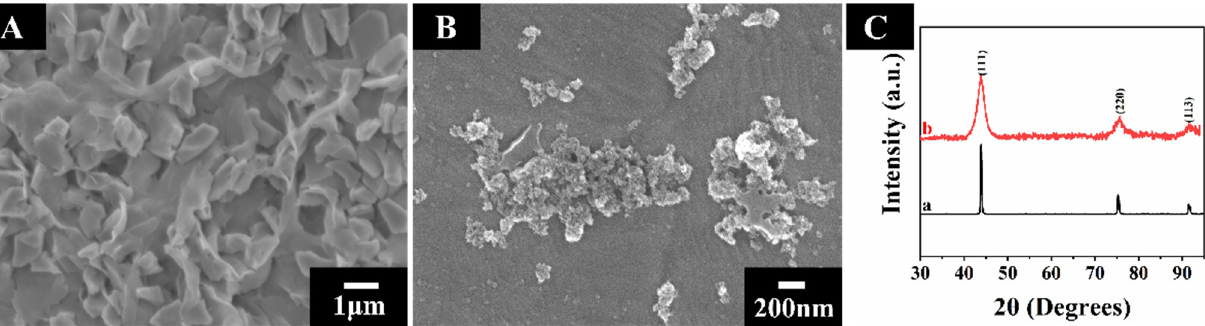
Figure 3. ( A , B ) SEM and ( C ) XRD data for films prepared from 1 gL ⁻ 1 CBXNa 2 solutions with ( A , C (a)) 1 gL ⁻ 1 diamond at 7 V in water and ( B , C (b)) 1 gL ⁻ 1 nanodiamond at 70 V in ethanol-water (5% water) solvent.